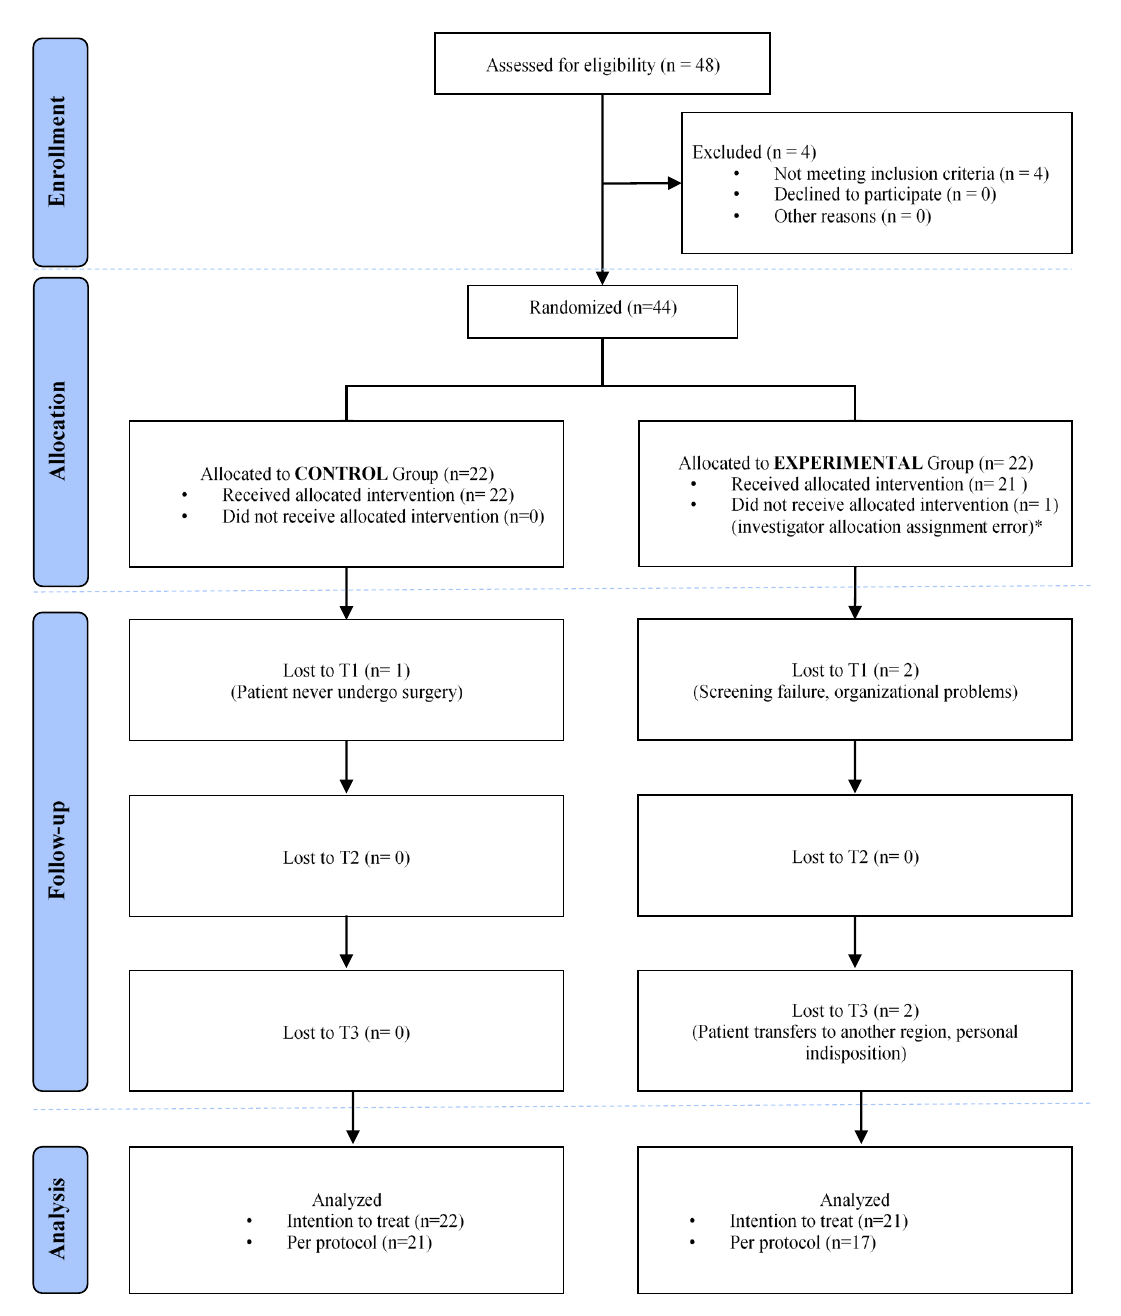
Figure 3. Study flow chart (CONSORT, 2010). * Following the allocation to the experimental group, one participant erroneously received the intervention assigned to the control group.